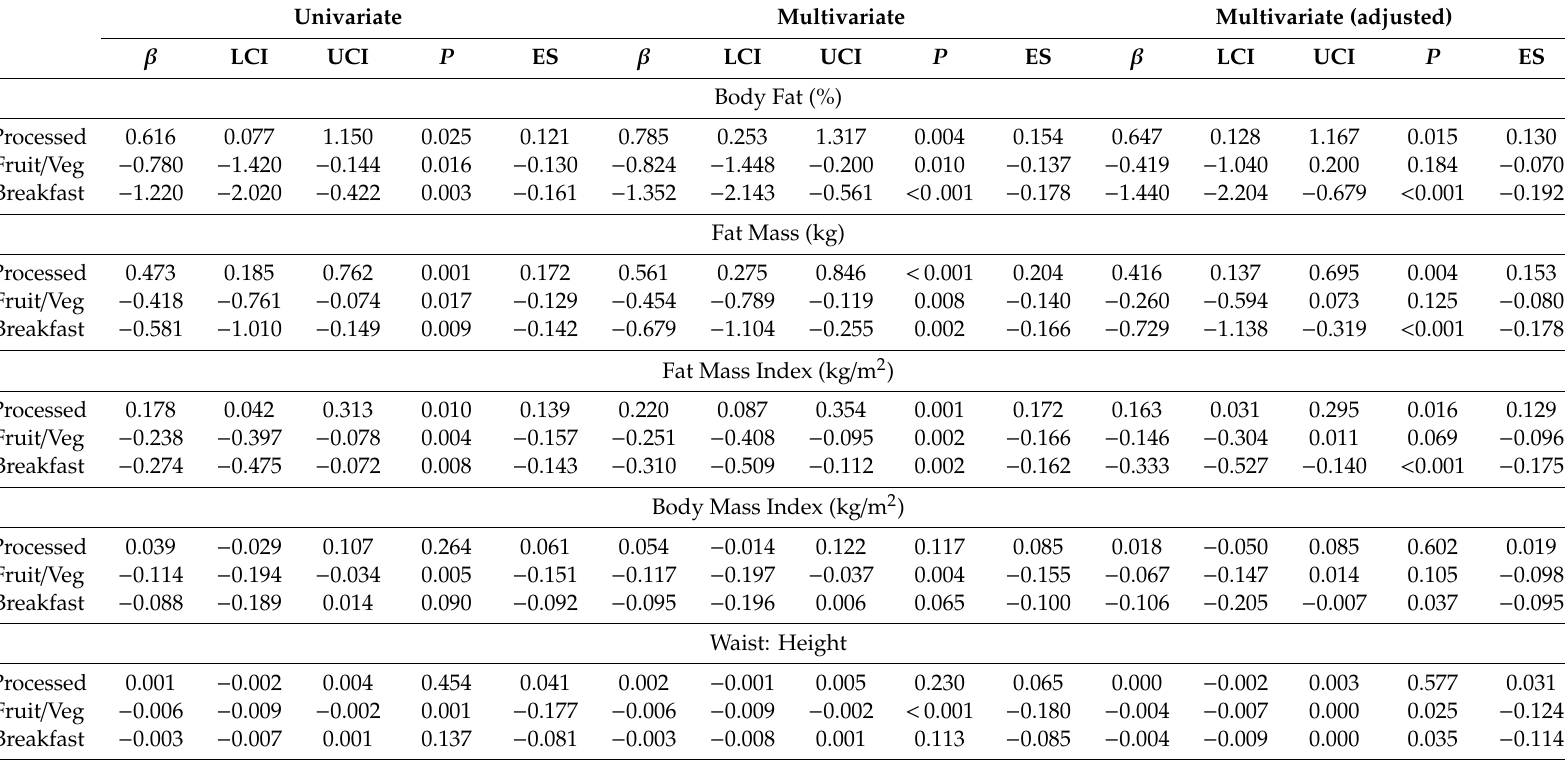
Table 3. Linear associations between body composition measures and food types ( n =